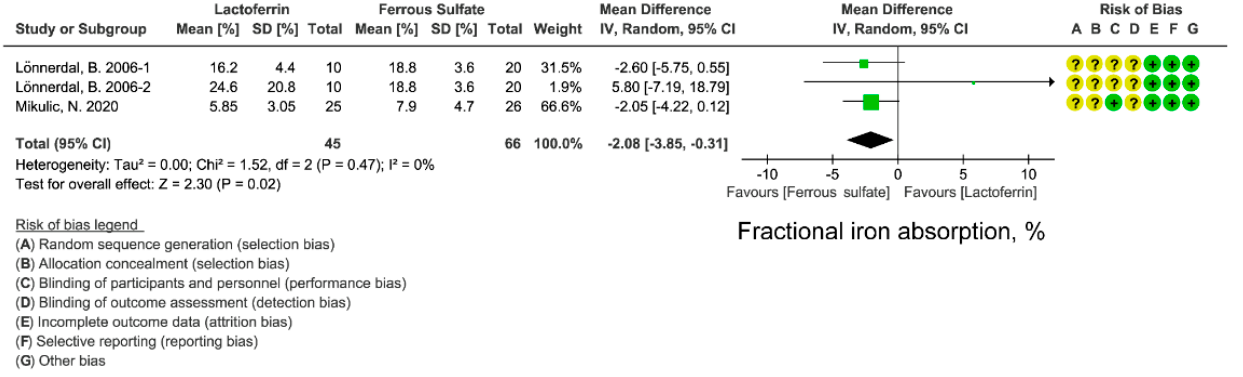
Figure 5. Effect of lactoferrin and ferrous sulfate on fractional iron absorption (FIA). Risk of bias legend: A = random sequence generation (selection bias); B = allocation concealment (selection bias); C = blinding of participants and personnel (performance bias); D = blinding of outcome assessment (detection bias); E = incomplete outcome data (attrition bias); F = selective reporting (reporting bias); G = other bias. Data expressed as weighted mean difference (95% CI). IV, inverse variance.